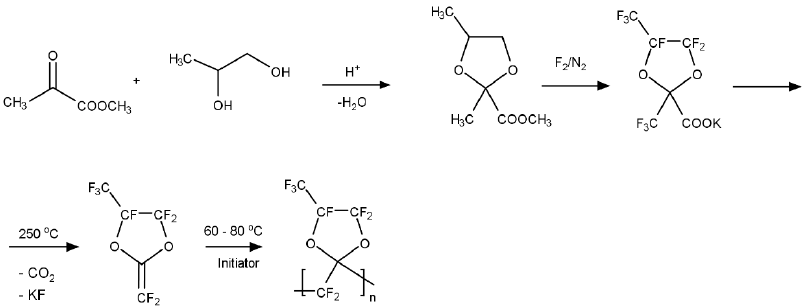
Figure 4. A typical synthetic route for a perfluorodioxolane monomer and the polymer. The case of poly(PFMMD) is shown.